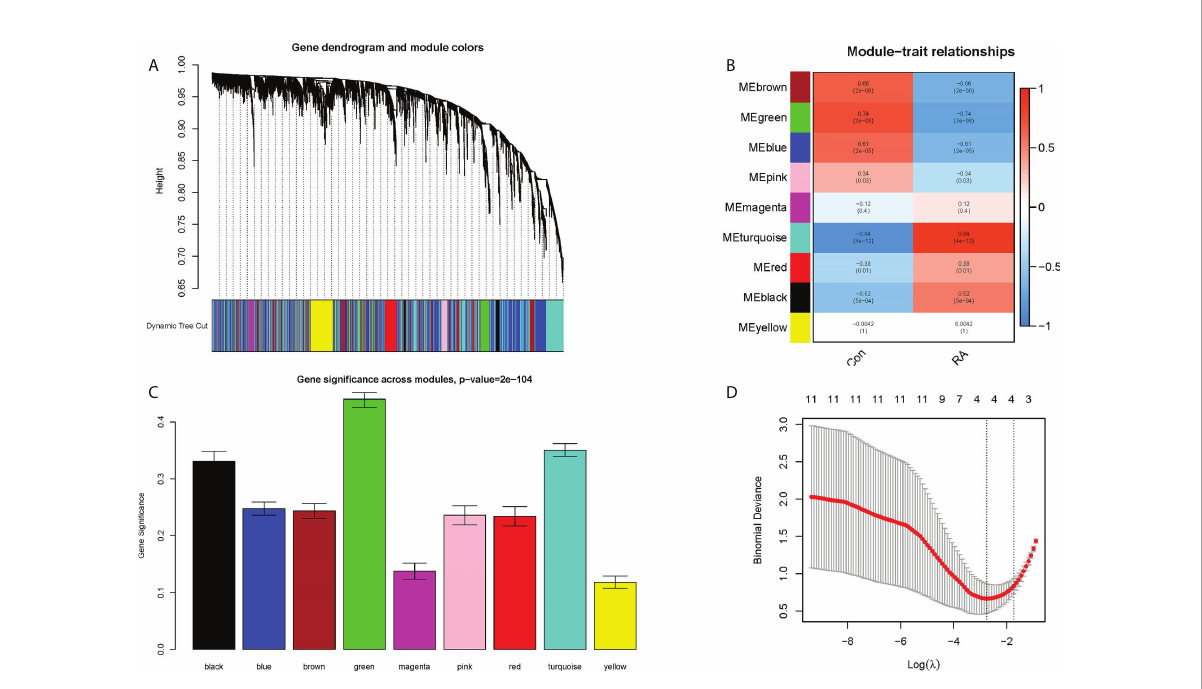
FIGURE 5 Screening of hub CRGs. (A) The cluster dendrogram of the genes. Each branch in the fi gure represented one gene, and every color below represented one co-expression module. (B) Heatmap of the module-trait relationships. (C) Distribution of average gene signi fi cance in the modules associated with the RA. (D) LASSO regression